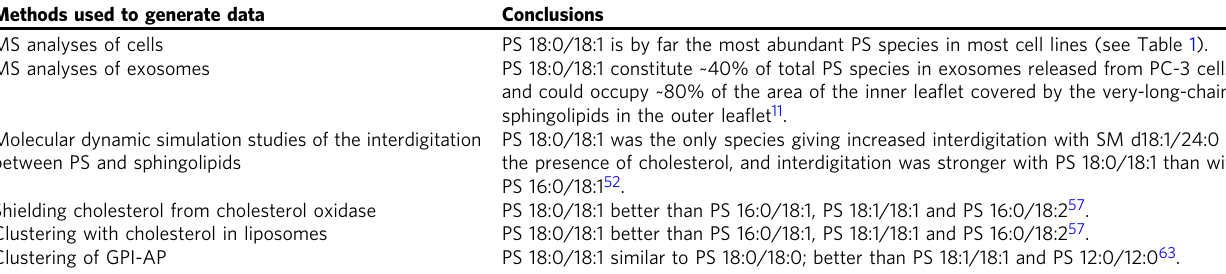
Table 3 Comparison of data obtained for PS 18:0/18:1 with those obtained for other PS species Methods used to generate data Conclusions MS analyses of